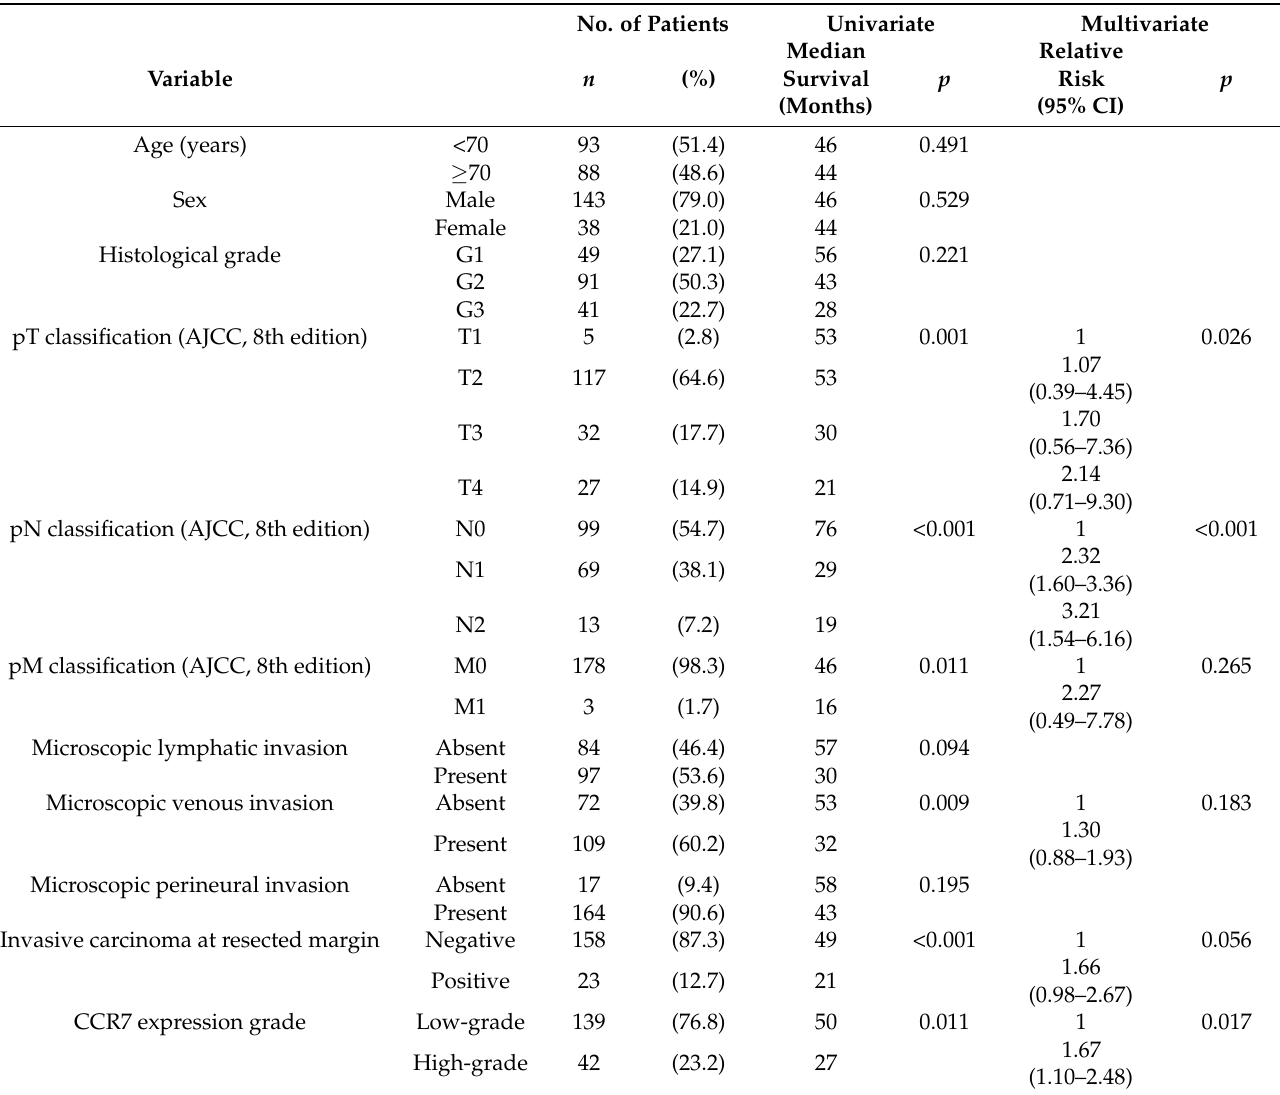
Table 2. Univariate and multivariate analyses of factors associated with the overall survival of the 181 patients with